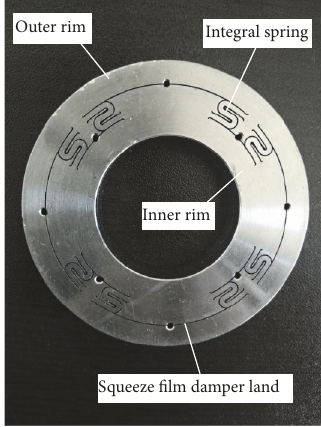
Figure 3: Experimental S-type